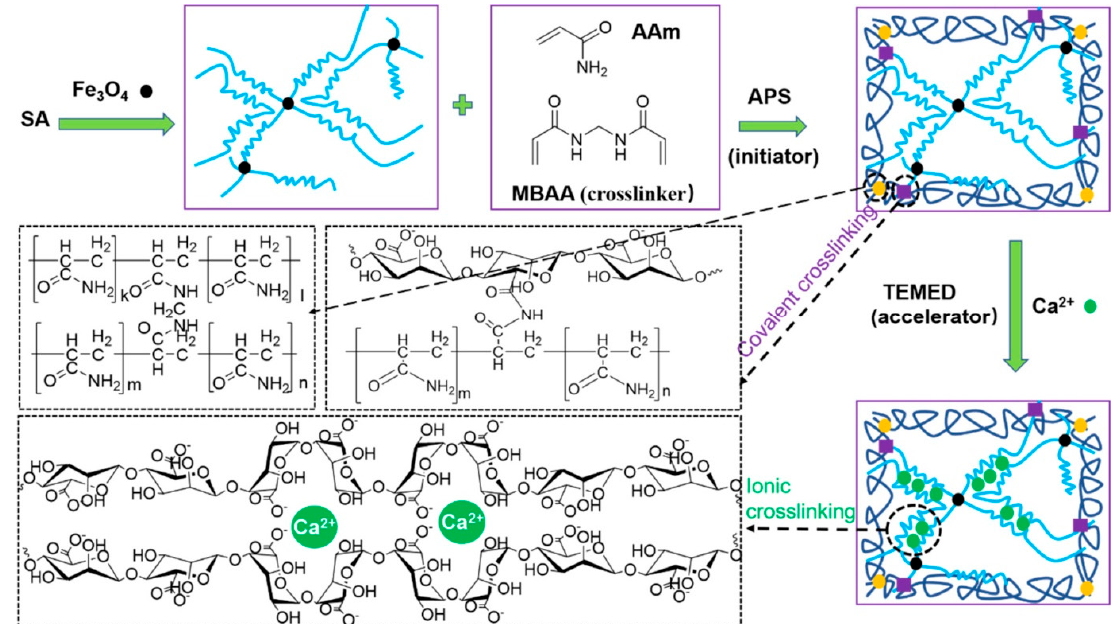
Figure 10. Schematic of reaction pathway to prepare a sodium alginate (SA)-based double-network magnetic hydrogel. During the gelation of ammonium persulfate (APS) N,N,N ′ ,N ′ -tetramethylethylenediamine (TEMED) and N,N ′ -methylenebis(acrylamide) (MBAA) were used as an activator and cross-linker, respectively [154] © 2021 American Chemical Society.